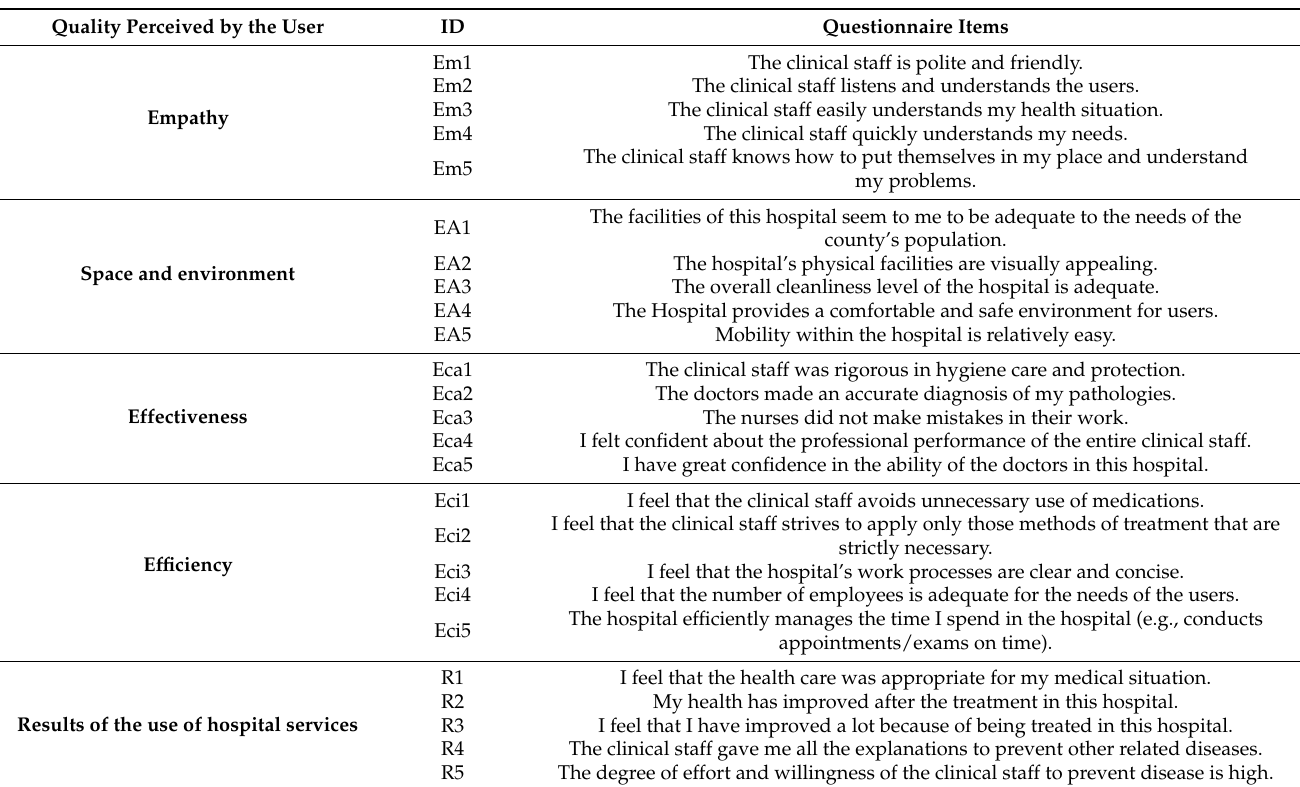
Table 2. Items of the variable perceived